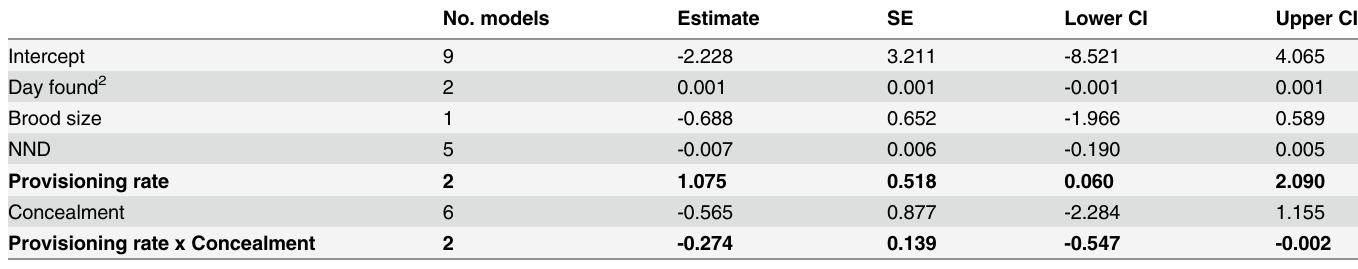
Table 4. Averaged model estimates and 95% confidence intervals from the top models predicting nestling stage failure (marginal R 2 = 0.56; condi- tional R 2 = 0.69). No.